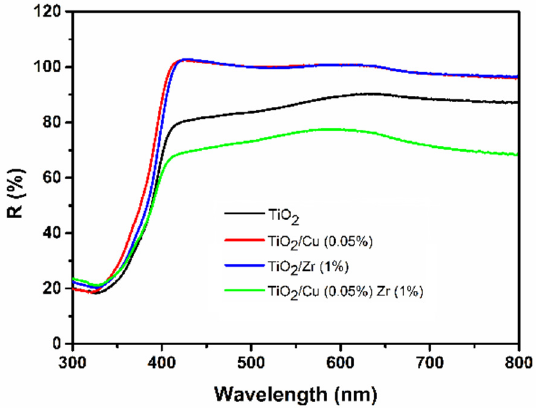
Figure 7. Diffuse reflectance spectra of unmodified and Cu- or/and Zr-modified TiO 2 recorded on a UV–Vis spectrophotometer.